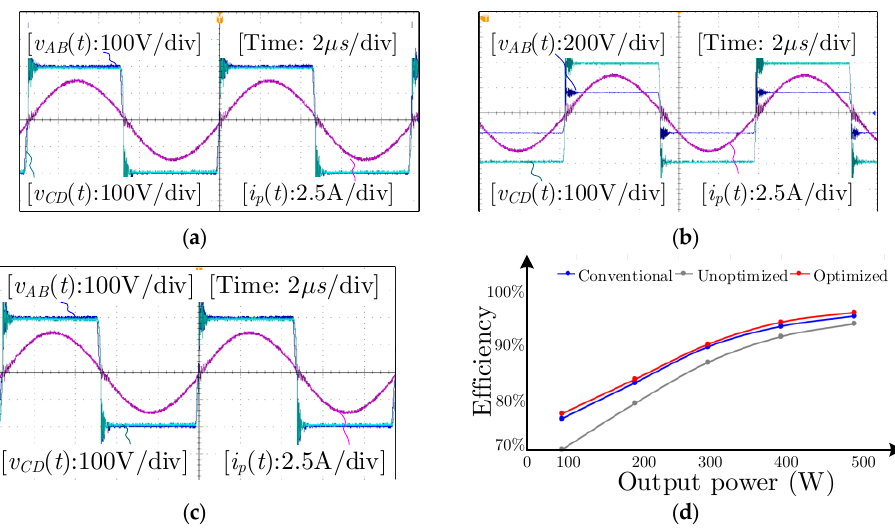
Figure 16. Experimental waveforms: ( a ) conventional planar transformer; ( b ) unoptimized pro- posed integrated magnetic structure; ( c ) optimized proposed integrated magnetic structure; ( d ) efficiency comparison.